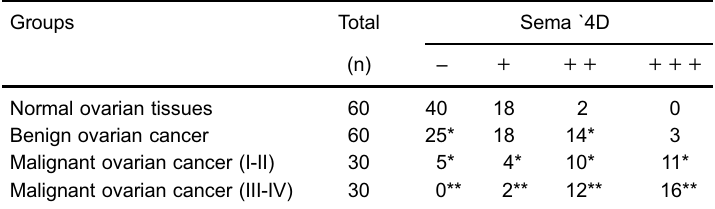
Sema 4D protein expression was assayed using immunohistochemistry. The results of immunohistochemistry were evaluated according to the quantity of positive cells and density of cell staining in the visual fi eld. Less than 5% positive scored 3; 76 – 100% scored 4. No or vague coloration in a visual fi eld was scored 0; pale yellow scored 1; medium yellow scored 2; brown scored 3. ( – ) means 0-1 scores; ( + ) means 2 – 3 scores; ( ++ ) means 4 – 5 scores; ( +++ ) means 6 – 7 scores. Ten visual fi elds were randomly selected in the single assay. Data are